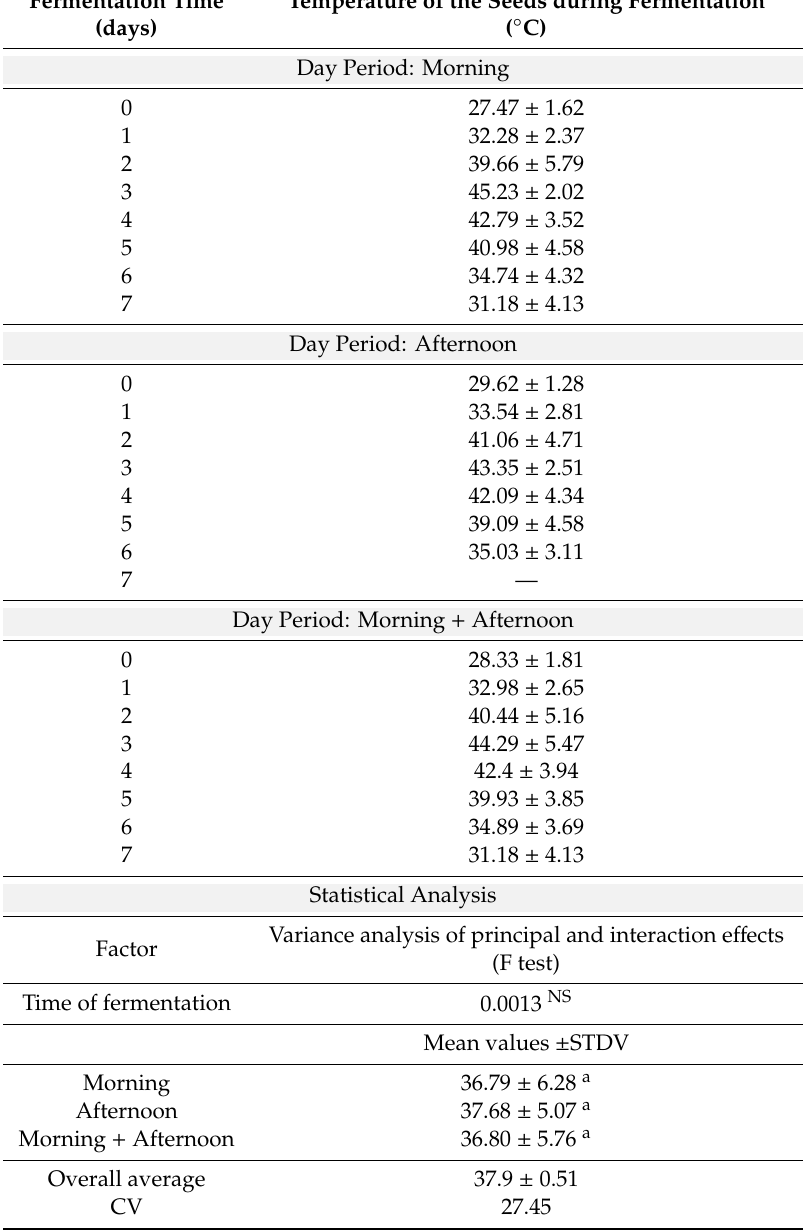
Table 1. Average values and standard deviations (mean ± STDV) from 3 analytical measures per batch (lot) of 5 lots and 2 sampling periods per each day (morning and afternoon) for the temperature parameters of the seeds throughout 6–7 days of controlled fermentation of cupuaçu seeds : average in morning; average in afternoon; and overall average (morning and afternoon). The initial, after fermentation, and after drying weights were, respectively: 100.0, 77.65, and 37.65 kg in lot 1; 100.0, 83.0, and 41.8 kg in lot 2; 100.0, 81.0, and 39.2 kg in lot 3; 100.0, 103.0, and 53.3 in lot 4; and 100.0, 82.0, and 39.5 in lot 5. Statistical analysis: F-tests Tukey post-hoc tests at 5% probability ( p ≤ 0.05) for the multiple comparison of mean di ff erences. Numbers from the same column with the same superscript letter are not significantly di ff erent, as obtained by the Tukey’s test ( p ≤ 0.05). NS = Not significant; * = Significant di ff erence ( p ≤ 0.05); ** = Significant di ff erence ( p ≤ 0.01); CV = Coe ffi cient of variation. Fermentation Time